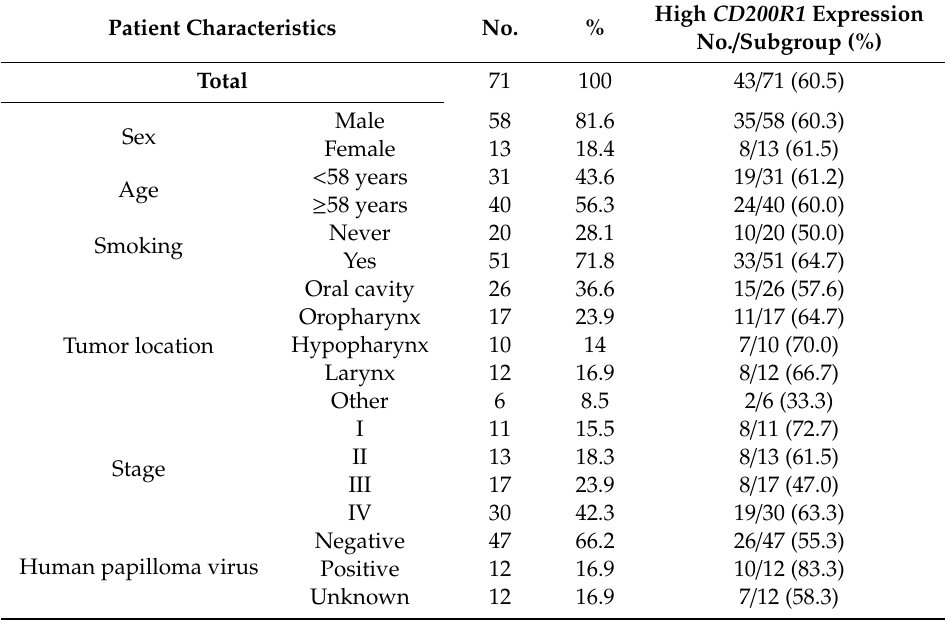
Table 1. C linical and pathological characteristics and CD200R1 mRNA expression in the Korean HNSCC cohort.